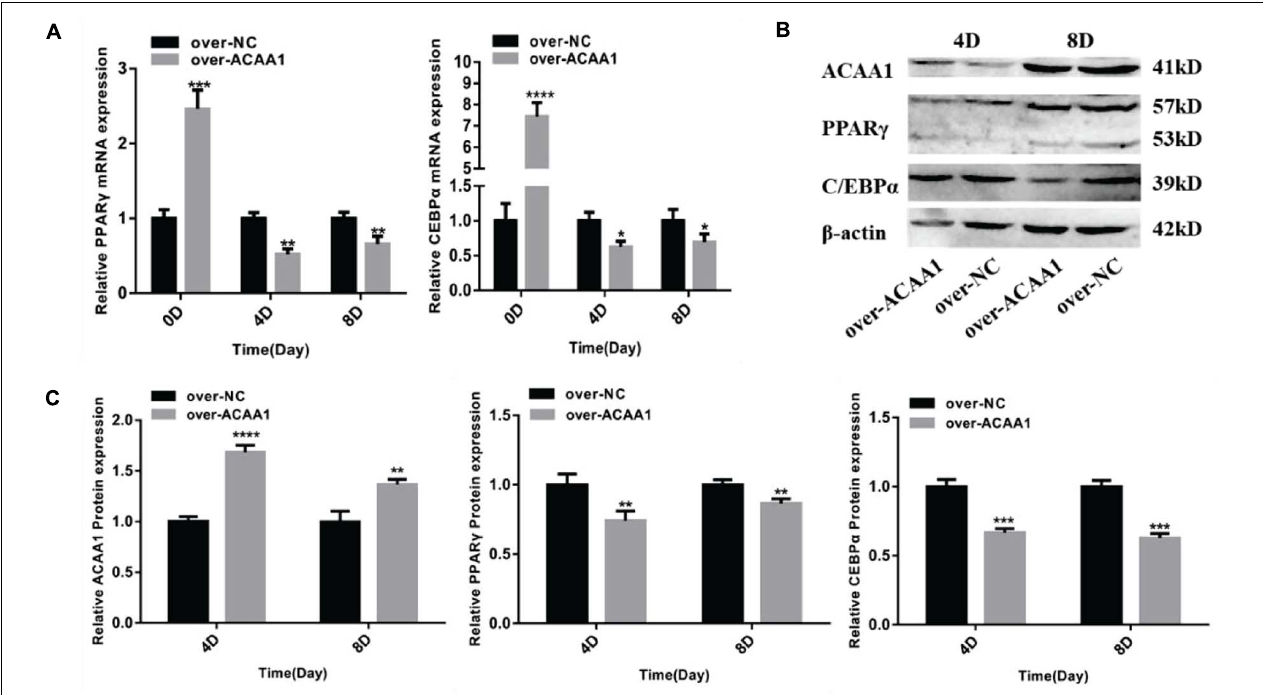
FIGURE 5 | ACAA1 overexpression regulates adipogenic marker gene expression. (A) Sheep preadipocytes were transfected with ACAA1 overexpression or negative control (NC) plasmids and differentiated into mature adipocytes. The mRNA expression levels of adipogenic marker genes ( PPAR γ and C/EBP α ) were measured on days 0, 4, and 8 of adipogenic differentiation. Except day 0, the mRNA expression levels of PPAR γ and C/EBP α were significantly lower than those of the control group (* p < 0.05, ** p < 0.01, *** p < 0.001, and **** p < 0.0001). (B) Protein expression levels of ACAA1 and adipogenic marker genes on days 4 and 8 of adipogenic differentiation. Columns 1 and 2 are the over-ACAA1 processing and over-NC processing groups, respectively (day 4). Columns 3 and 4 are the over-ACAA1 processing and over-NC processing groups, respectively (day 8). β -actin is the internal reference gene. (C) The protein expression levels of ACAA1 and adipogenic marker genes were assessed on days 4 and 8 of adipogenic differentiation. The protein expression levels of ACAA1 were significantly higher than those of the control group (**** p < 0.0001 and ** p < 0.01), and the protein expression levels of PPAR γ and C/EBP α were significantly lower than those of the control group (** p < 0.01 and *** p <